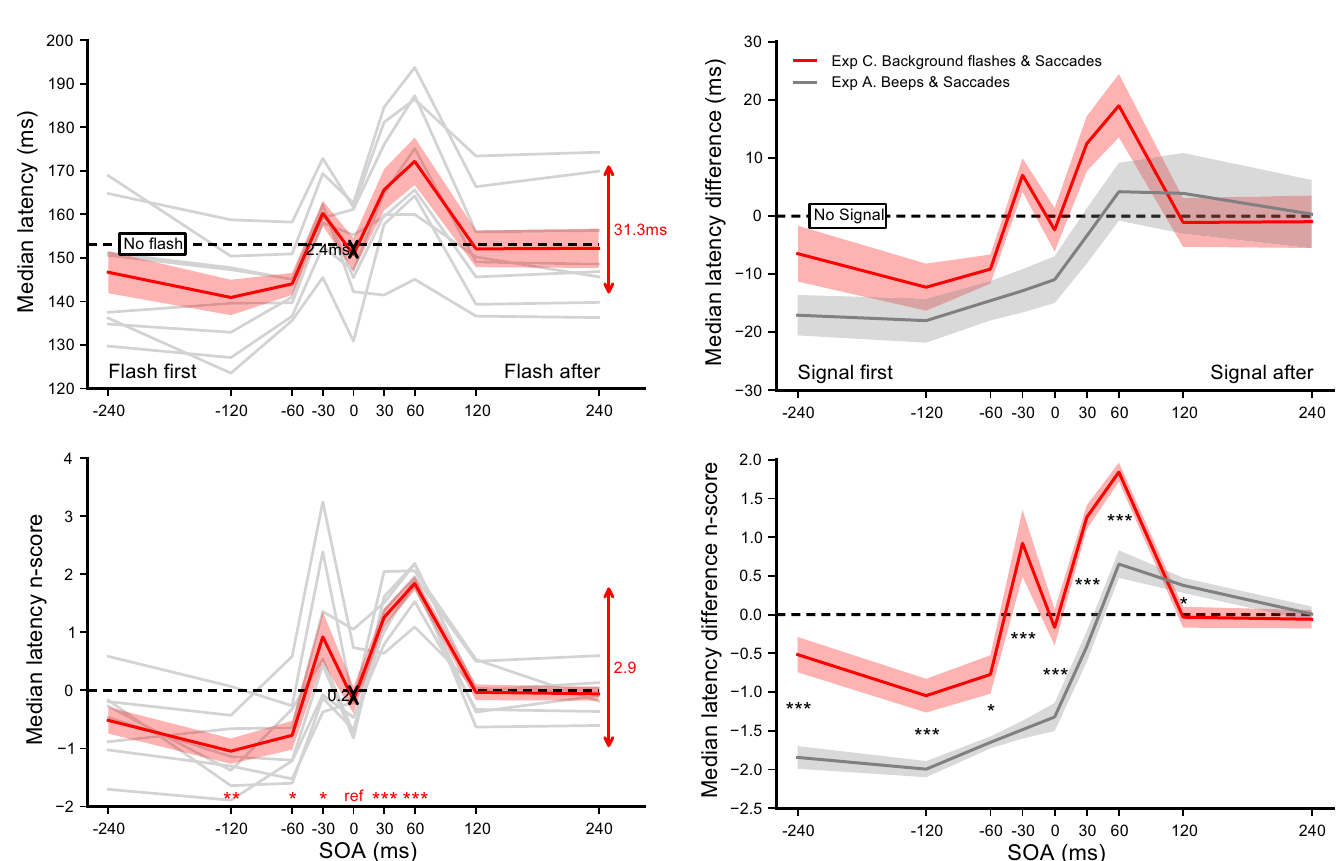
Fig 4. Experiment C. Effect of background flashes on saccade onset (left panel). Median latencies averaged across participants for each SOA condition (top) and the corresponding n scores (bottom). Dashed lines show the No flash condition level and grey lines show individual results. Error bars indicate inter-individual SEM. Statistics included a single sample t-test performed on the n scores of the SOA = 0 ms reference condition to highlight the difference with the No flash condition (black arrow), and paired t-tests comparing this reference with each of the other SOA condition (red stars for each SOA above the X-axis). Auditory beeps vs. visual background flashes (right panel). Comparison between experiment C (red plot) and A (grey plot): median latency differences (top) and n score differences (bottom) aligned on the No signal conditions (dashed lines). Statistics were unpaired t-tests performed on the n score differences between experiments for each of the 9 SOA conditions. Three stars indicate highly significant differences after Bonferroni correction (p < 0.00555), single stars and two stars significant differences without correction (p < 0.05 and p < 0.01 respectively). Red arrows indicate the overall range of